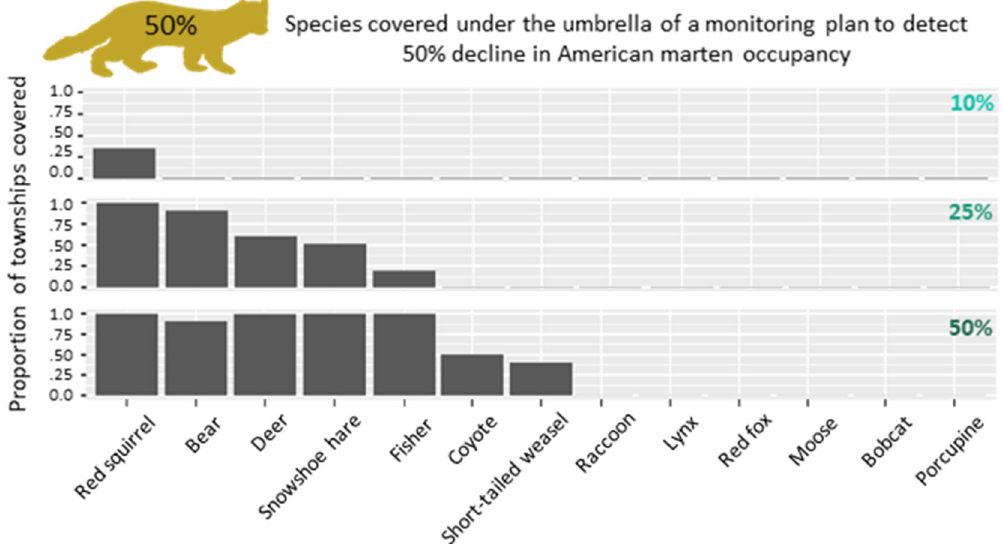
Figure 5. Umbrella effect (50% marten decline). The figure shows the proportion of townships per species that are covered under the 50% marten decline sampling protocol: top are covered at a 10% decline, middle at a 25% decline, and bottom at a 50%